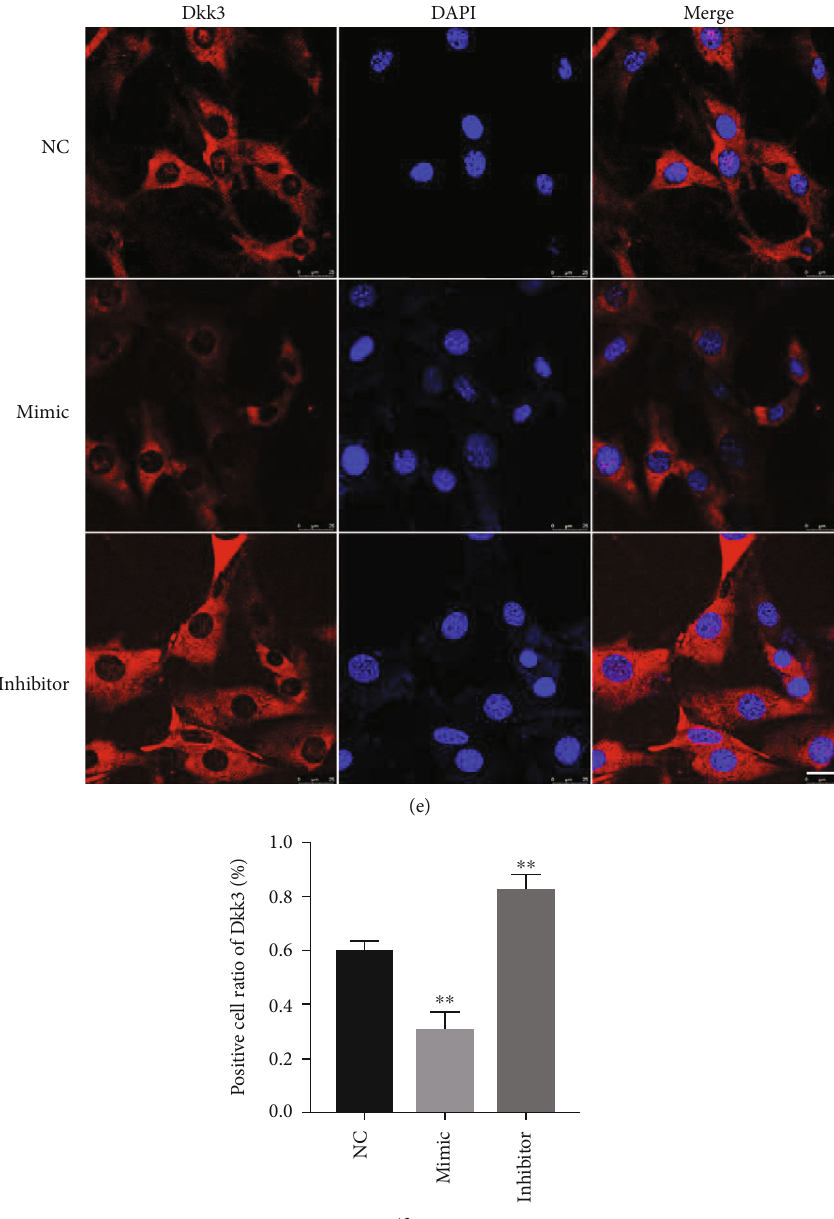
Figure 6: Dkk3 is a direct target of miR-129-5p. (a) A diagram showed potential targets of miR-129-5p analyzed by TargetScan, miRDB, and miRWalk. (b) Bioinformatics prediction of miR-129-5p binding sites in the 3 ′ UTR of Dkk3 mRNA. (c) Luciferase activities of reporters containing the 3 ′ UTR of Dkk3 in miR-129-5p-transduced, miR-129-5p-mutant-transduced, or negative control 293T cells. The relative luciferase activity in 293T cells cotransfected with negative control was designated as 1. (d) Protein levels of Dkk3 were examined by western blot. (e) Representative image of immuno fl uorescence staining with Dkk3 (red) antibody and DAPI (blue) in BMSCs transduced with the indicated lentivirus. Scale bars, 25 μ m. (f) Quanti fi cation of Dkk3-positive cells in analysis was shown at (f) ( n = 4 ). ∗ p < 0 : 05 and ∗∗ p < 0 : 01